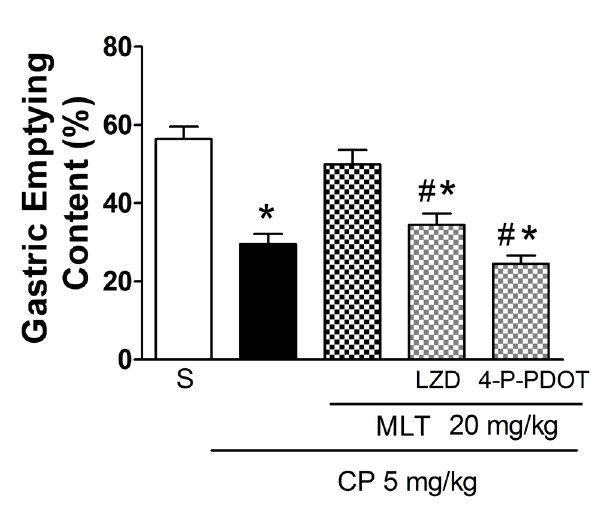
FIGURE 3 - Effects of melatonin (MLT) on the percentage of gastric dye emptied, as induced by cisplatin (CP) in mice pretreated with luzindole (LZD, 5 mg/kg) or 4-phenyl- 2-propionamidotetralin (4-P-PDOT, 4 mg/kg). P < 0.05, *compared with the control group (S), # compared with the group treated only with MLT (ANOVA followed by Tukey